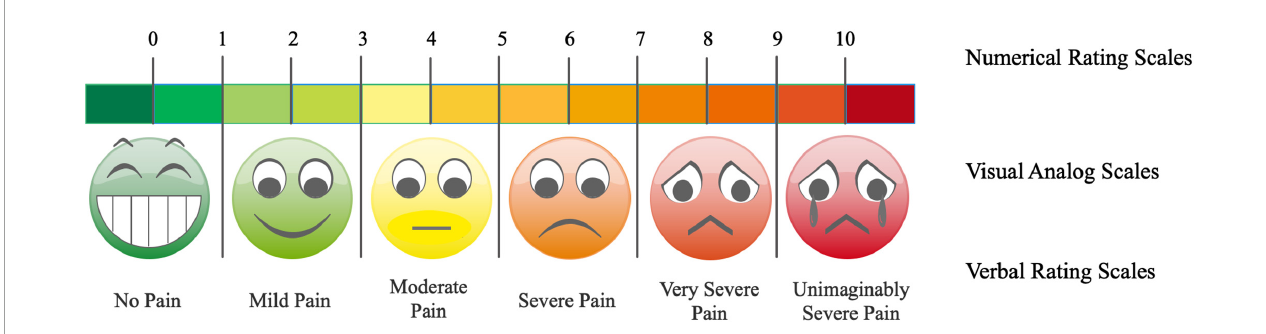
FIGURE1 Tradition assessment tools for pain intensity. The Numerical Rating Scales (NRS), Verbal Rating Scales (VRS), and Visual Analog Scales (VAS) are the most commonly used pain intensity assessment